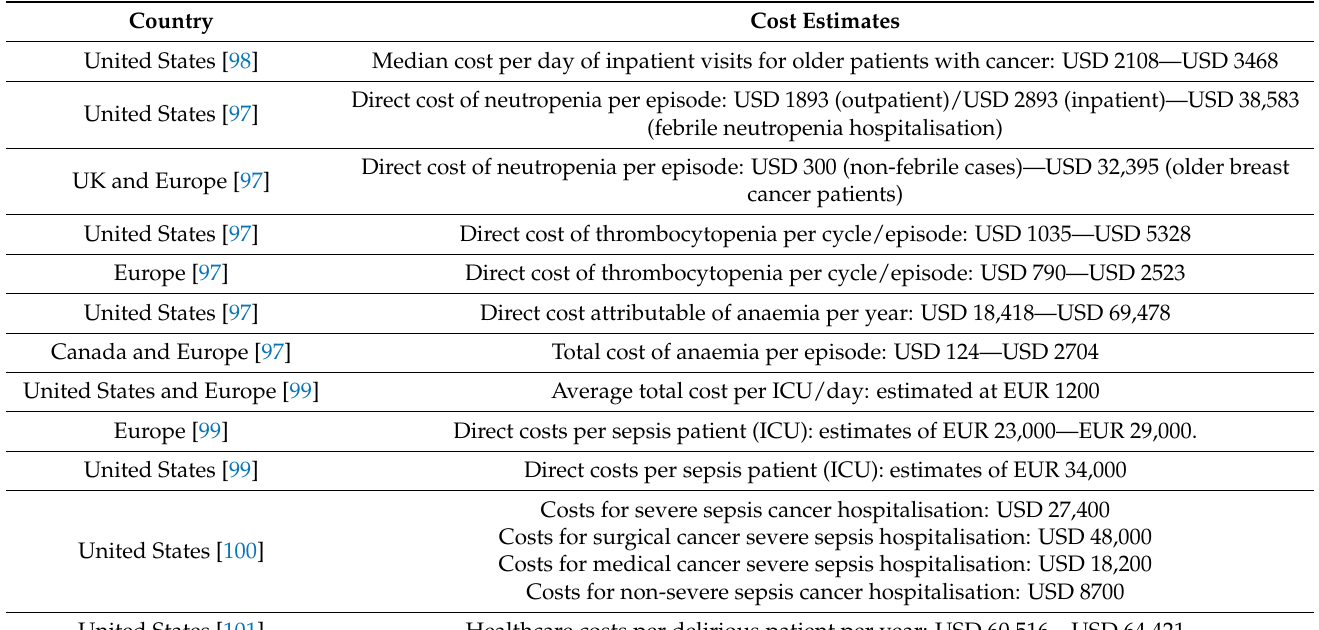
Table 5. Costs for hospitalisation and adverse events